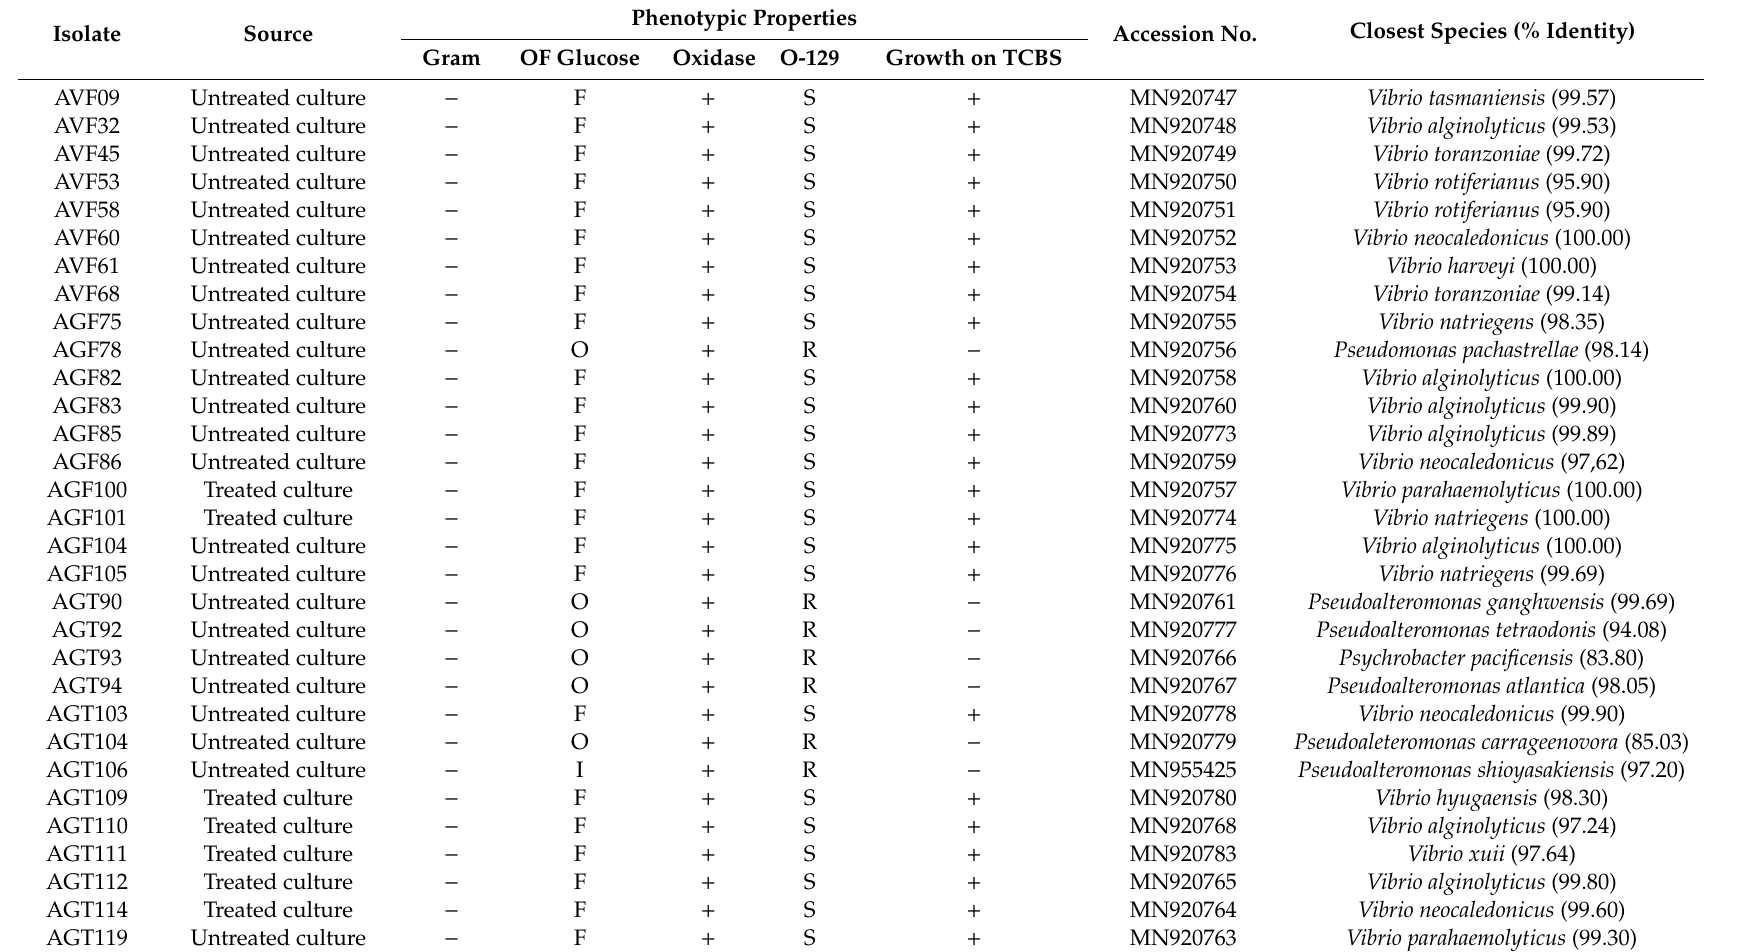
Table 3. Identification, source, and phenotypic properties of florfenicol-resistant isolates recovered from Artemia cultures.